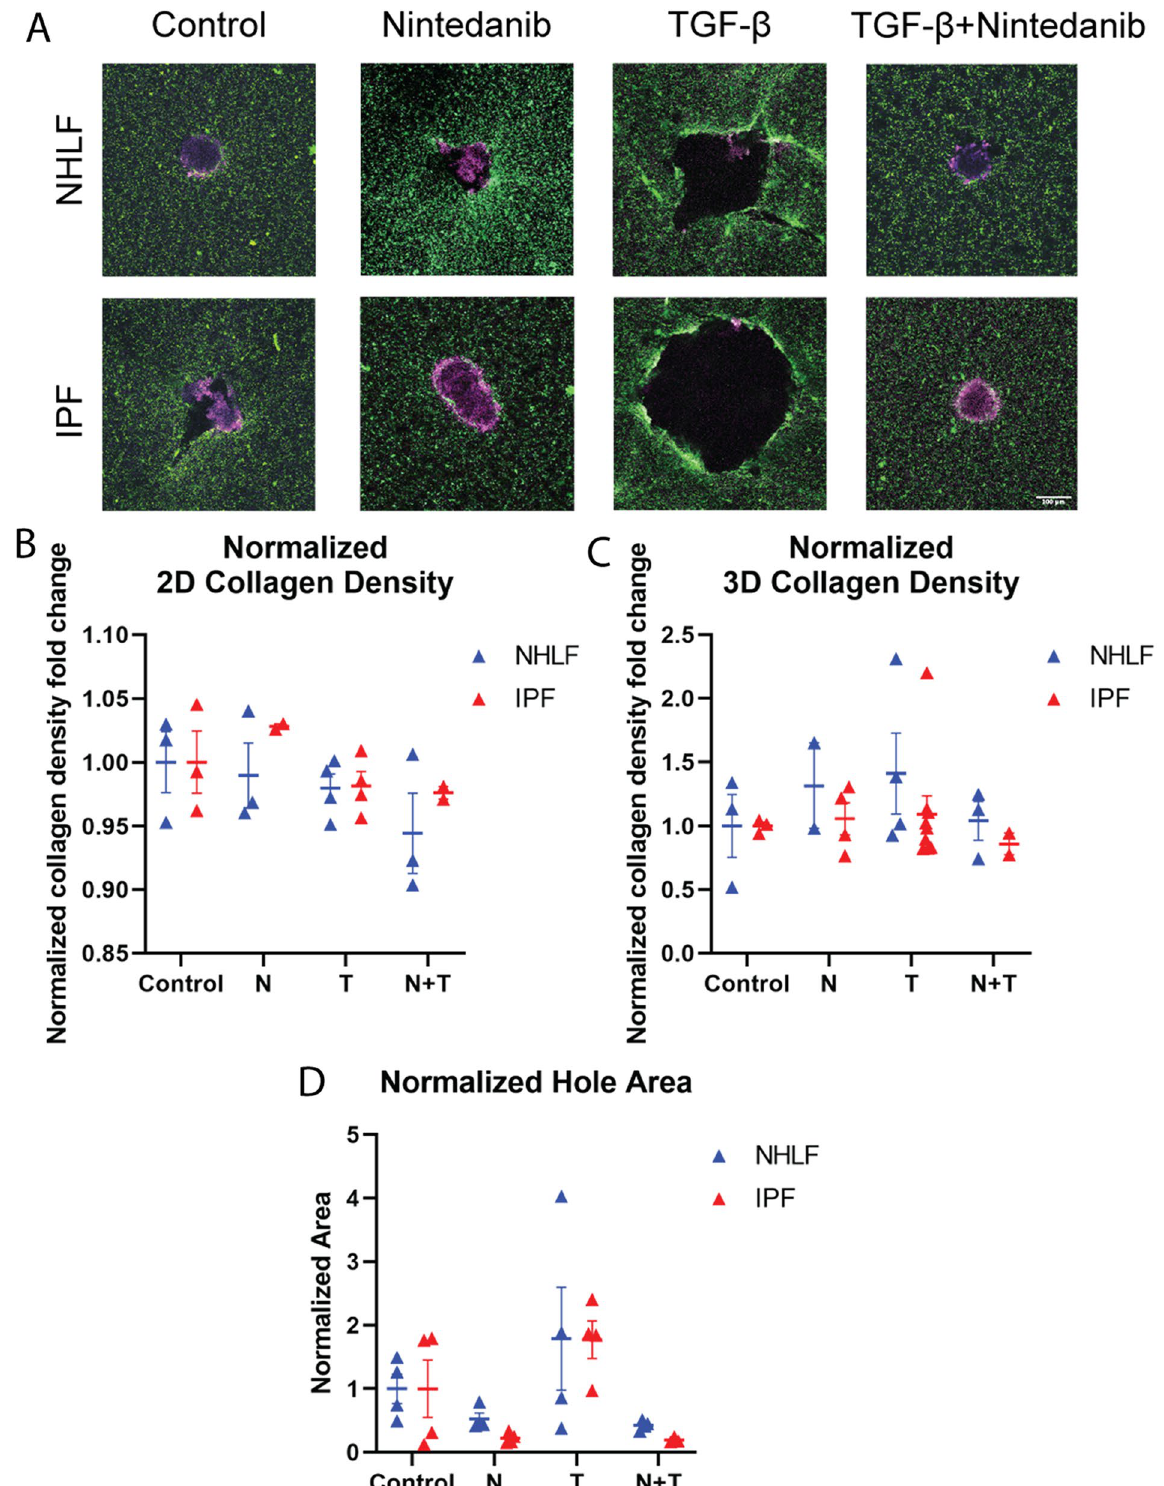
Figure 3. Analyses of TGF-β and Nintedanib-treated spheroids. ( A ) Day 5 NHLF29800 and IPF29548 spheroids treated with Nintedanib, TGF-β, TGF-β + Nintedanib. Scale bar, 100 μm. ( B ) 2D collagen density fold change at hour 6 normalized by the TGF-β only condition for NHLF29800 and IPF29548 spheroids (each data point is a spheroid). ( C ) 3D collagen density fold change at hour 6 normalized by the TGF-β only condition for NHLF29800 and IPF29548 spheroids (each data point is a spheroid). ( D ) Day 7 hole size normalized by the TGF-β only condition for NHLF29800 and IPF29548 spheroids in different conditions (each data point is a spheroid). T stands for TGF-β. N stands for